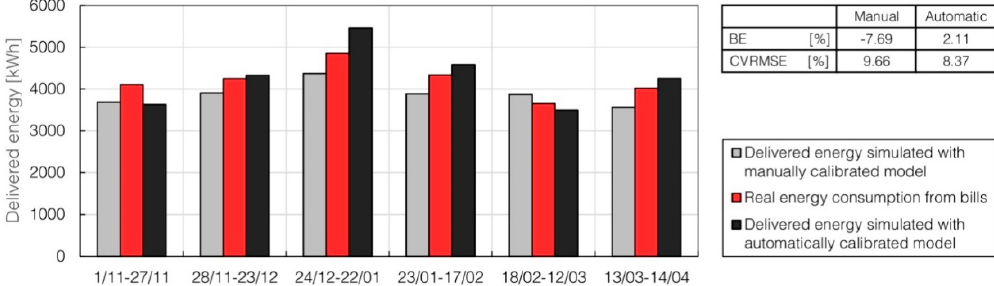
Figure 17. Delivered energy from manual and automatic calibrated models compared with real consumption from bills.